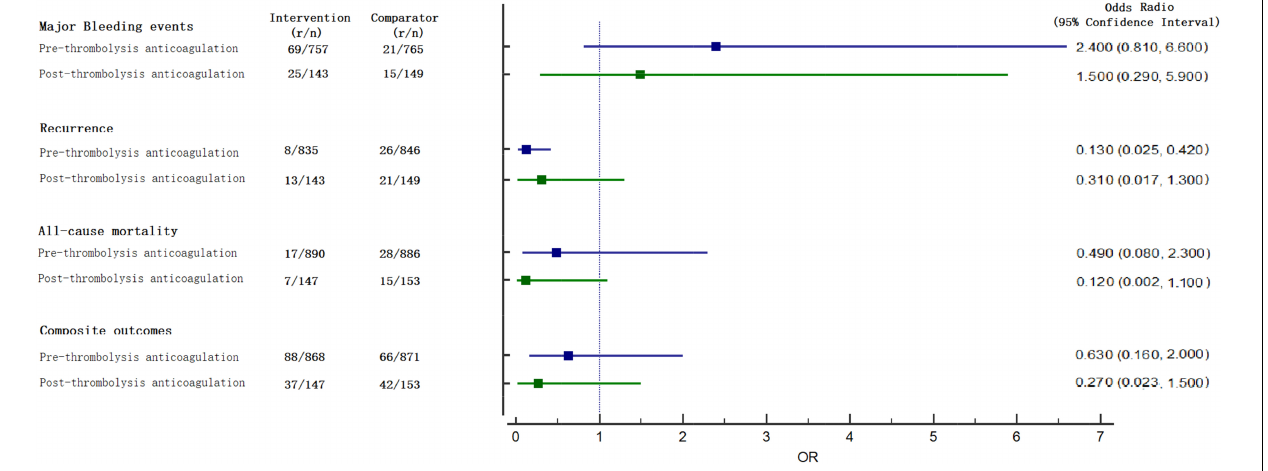
FIGURE 3 | Forest plots for relative effect as compared with